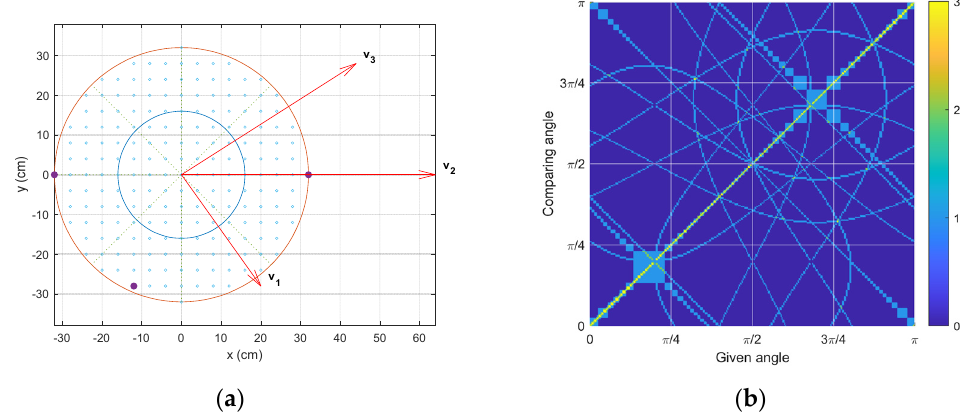
Figure 7. Optimal similarity outcome, which shows the lowest similarity matrix L 1,1 norm. ( a ) One of the best configurations for the three-receiver structure. ( b ) The corresponding similarity matrix.